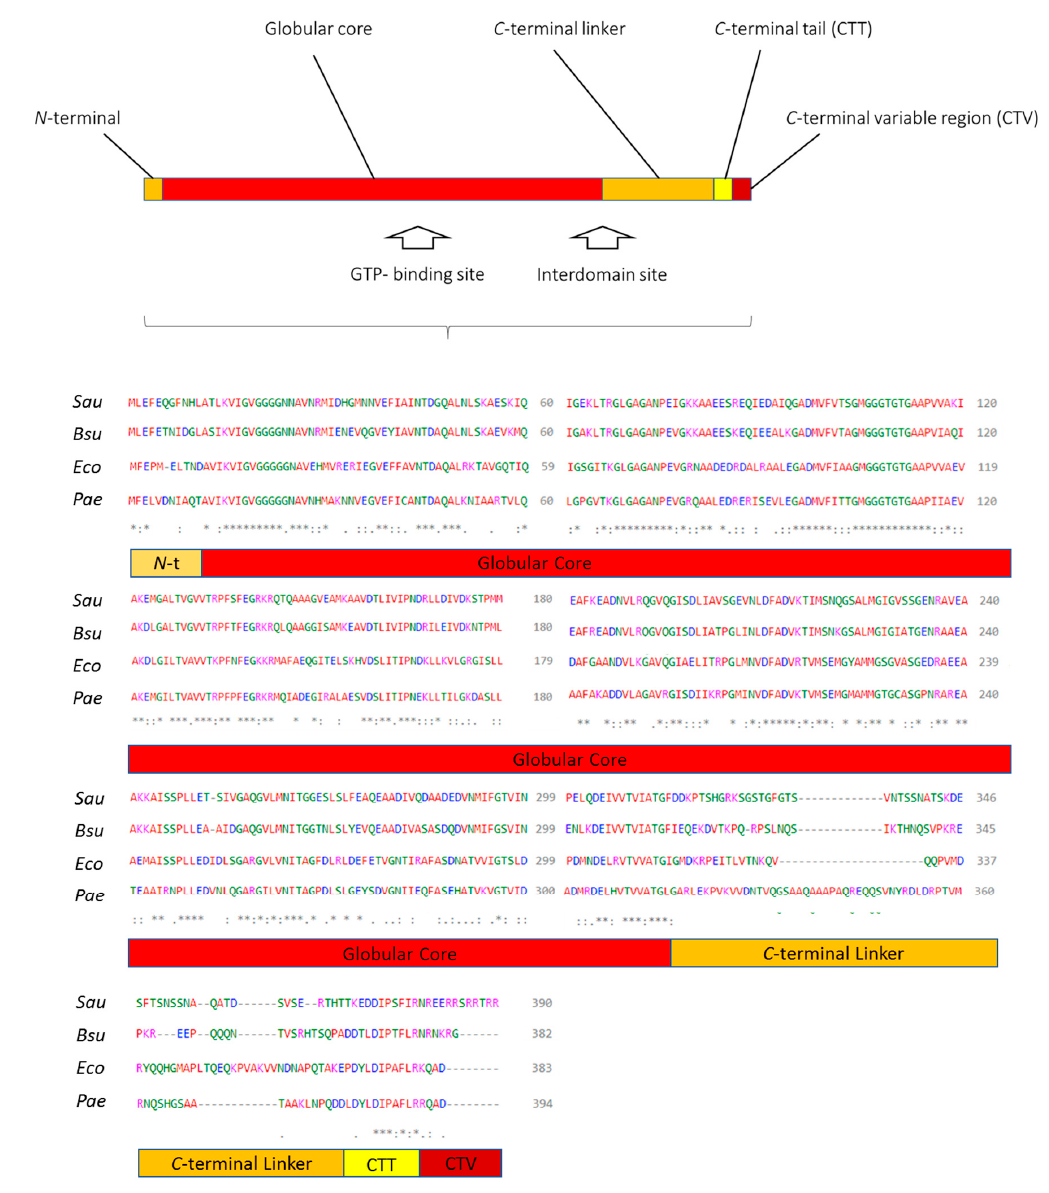
Figure 1. Graphical representation of FtsZ main subunits and sequence alignment of FtsZ from representative organisms: Staphylococcus aureus ( Sau ), Bacillus subtilis ( Bsu ), Escherichia coli ( Eco ), and Pseudomonas aeruginosa ( Pae ). Alignments: * = same residues, : = equivalent residues, · = partial alignment. The sequences were obtained from uniport.org (identifiers (IDs): P0A031, P17865, P0A9A6, P47204) and aligned with EMBL-EBI Clustal Omega (www.ebi.ac.uk/Tools/msa/clustalo/).